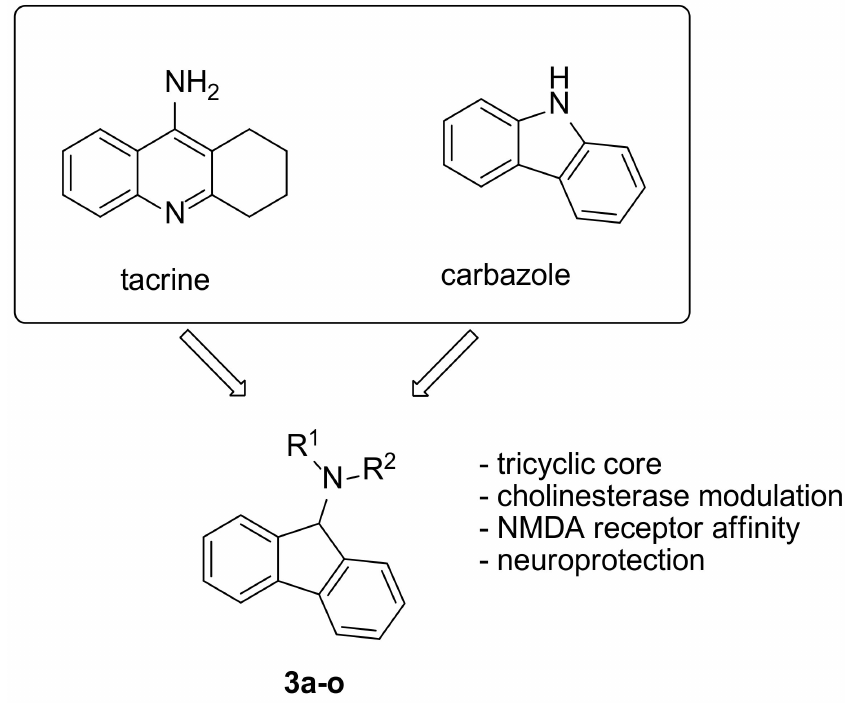
Figure 1. Design of a novel 9-aminofluorene overlapping the tacrine (THA) and carbazole moieties. NMDA: N -methyl- D